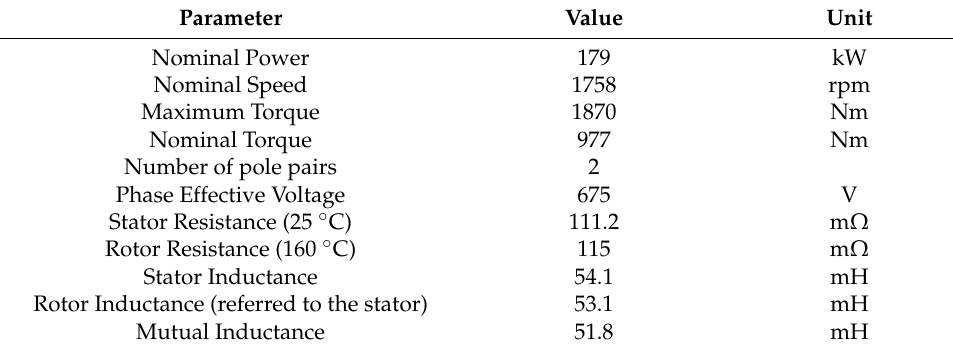
Table 2. Nominal parameters of the motor under test.